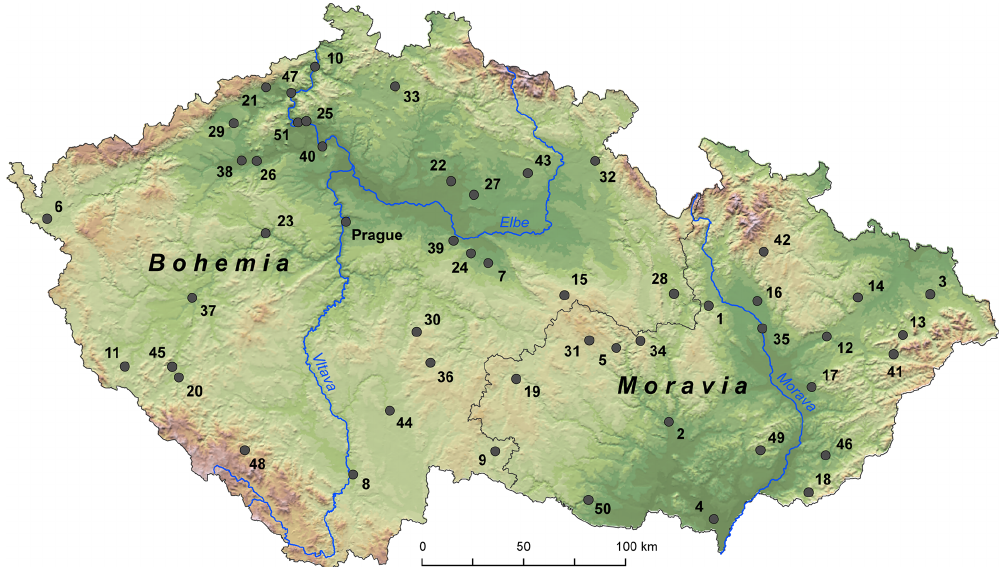
Figure 1. Location of places reported in the Czech Republic: 1 – Bouzov; 2 – Brno; 3 – Bruzovice; 4 – Bˇreclav; 5 – Bystˇrice nad